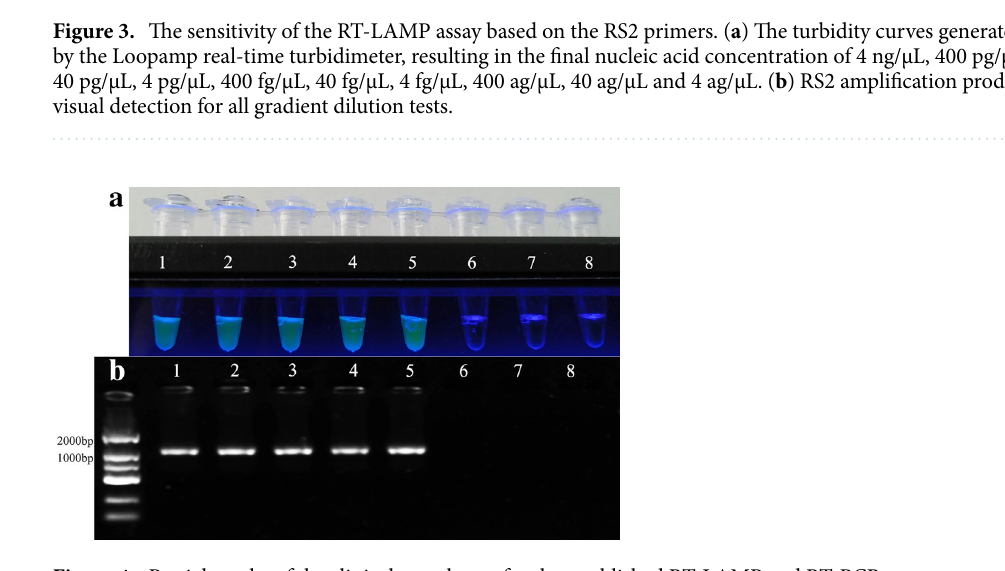
Figure 4. Partial results of the clinical sample test for the established RT-LAMP and RT-PCR assays reported in this study. ( a ) RT-LAMP amplification products visual detection for the five artificial positive samples, two negative samples and blank. (2) RT-PCR result based on agarose gel (1%) electrophoresis. Lane 1 to 5: five artificial positive samples; Lane 6 and Lane 7: two negative samples; Lane 8: water